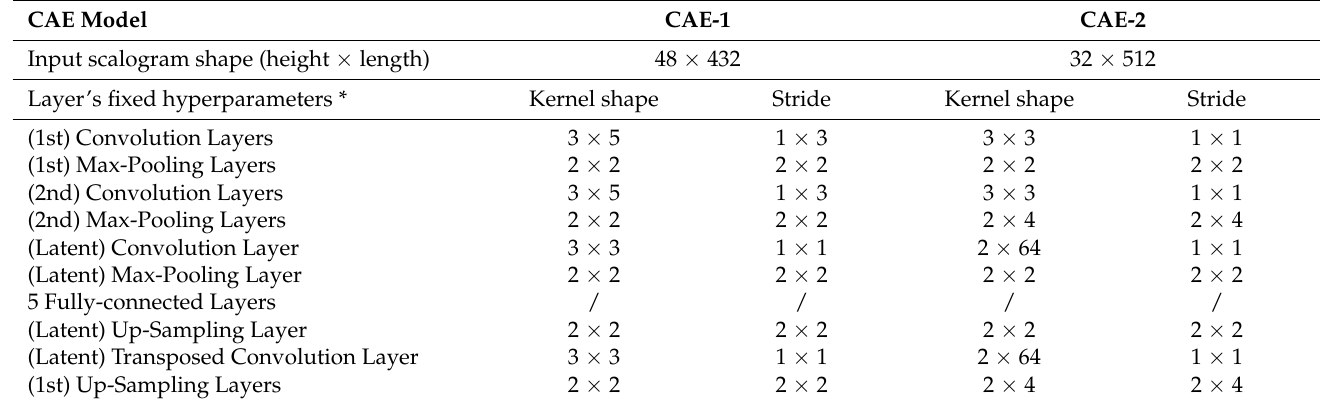
Table 2. Comparison of CAE models regarding kernel shapes and